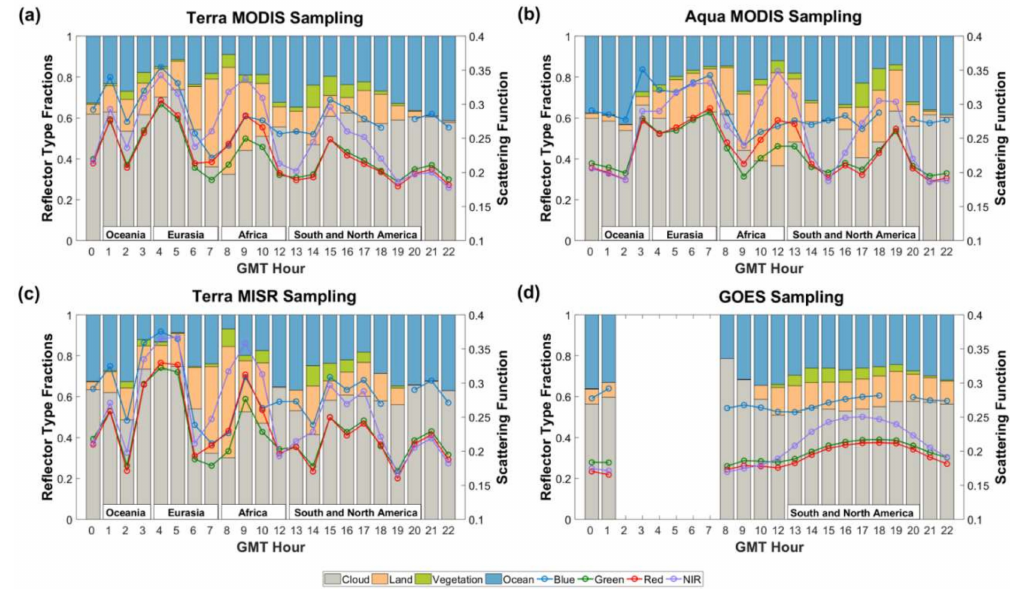
Figure 7. Diurnal variations of the fractional coverage of different Earth components (left vertical axis) and scattering functions at blue (443 nm), green (551 nm), red (680 nm) and NIR (780 nm) wavelengths (right vertical axis) averaged over the sampling areas of ( a ) Terra MODIS, ( b ) Aqua MODIS, ( c ) Terra MISR and ( d ) GOES-East for EPIC images acquired on 23 August 2016. Sampling areas are shown in Figure 1. Continents present in the image are shown on the horizontal axis.